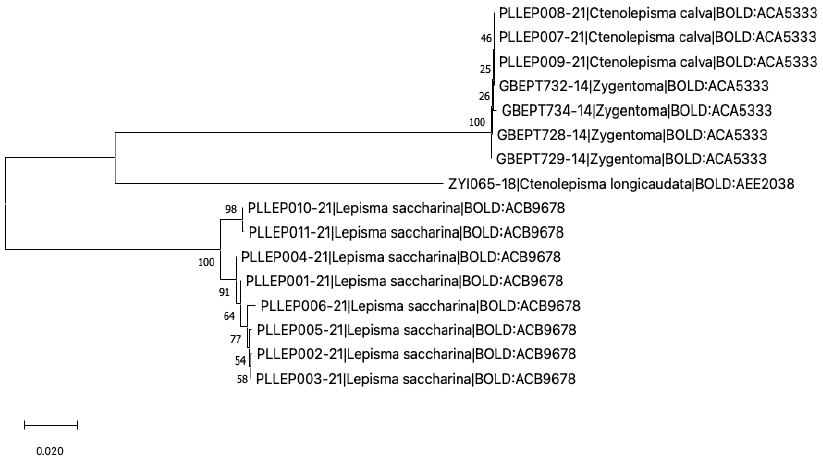
Figure 7. Neighbor-joining tree of the COI sequences representing Ctenolepisma calvum , C. longi- caudatum , and Lepisma saccharinum . Numbers next to nodes are bootstrap values.